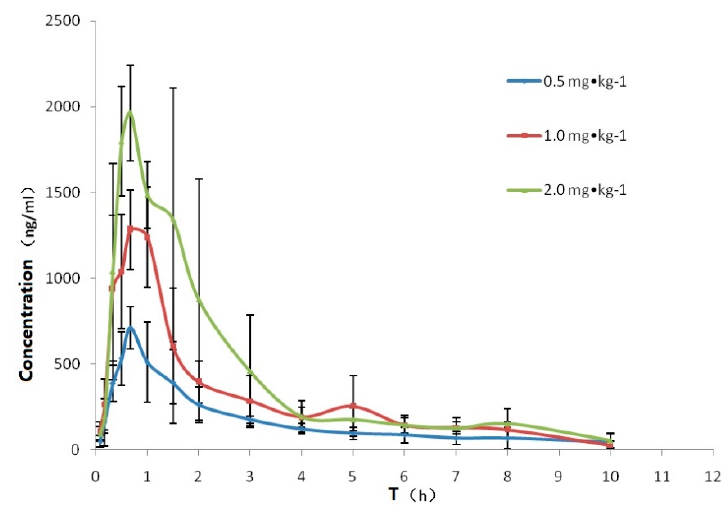
Figure 7. Plasma concentration–time curves for lansoprazole in three dose groups. Each point represents the mean ± S.D ( n = 6).